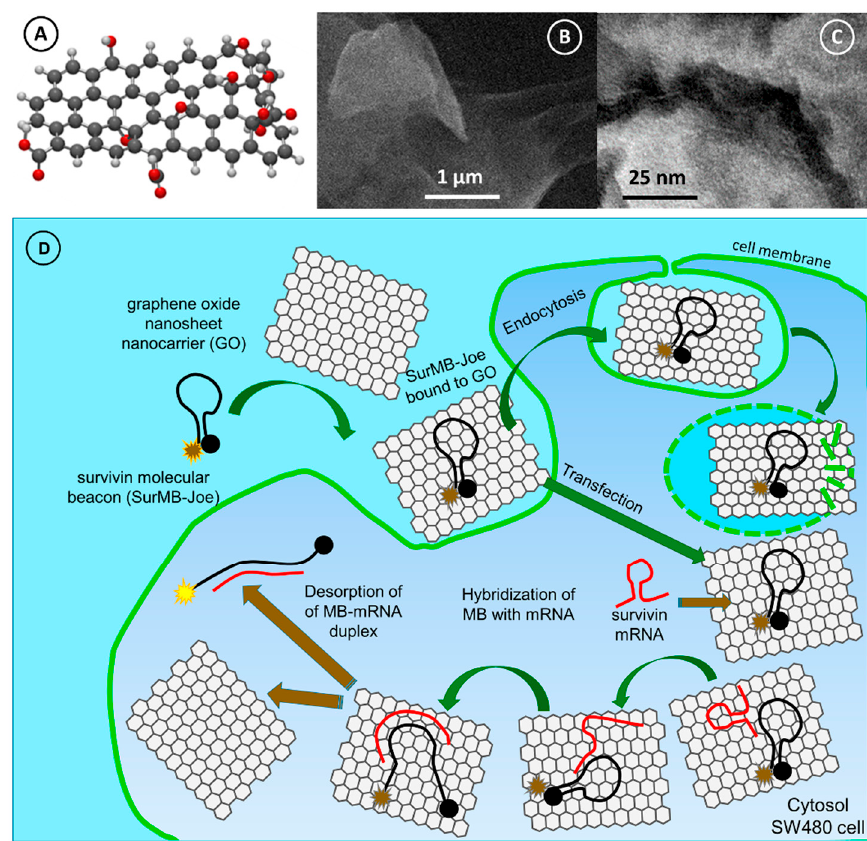
Figure 5. ( A ) Structure of a model graphene oxide nanosheet nanocarriers (GO); ( B ) SEM image of GO nanocarriers; ( C ) TEM image of GO; ( D ) Principle of the internalization of the GO-bound SurMB-Joe (GO@SurMB-Joe) to SW480 cells.